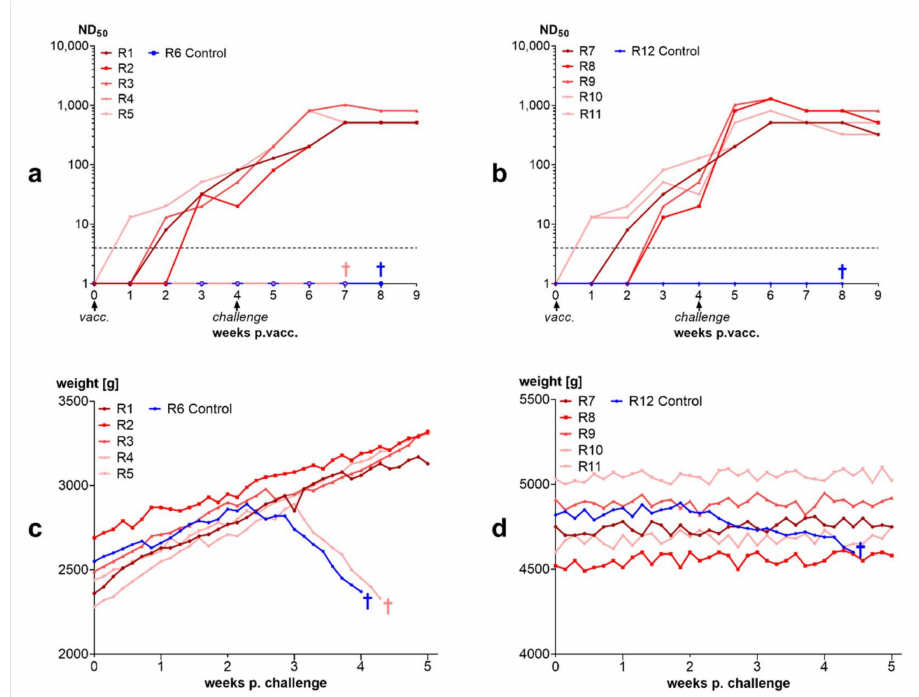
Figure 7. Neutralizing (NT) antibody titer kinetics in rabbits vaccinated with BoDV-1 live vaccine “Dessau” after ( a ) heterologous challenge infection with BoDV-1 V/B or ( b ) homologous challenge infection with the BoDV-1 vaccine virus “Dessau”. Body weight development after the respective challenge infections is shown in ( c , d ). Dashed lines, IF and NT assay limits of detection; †, animal euthanized before succumbing to lethal